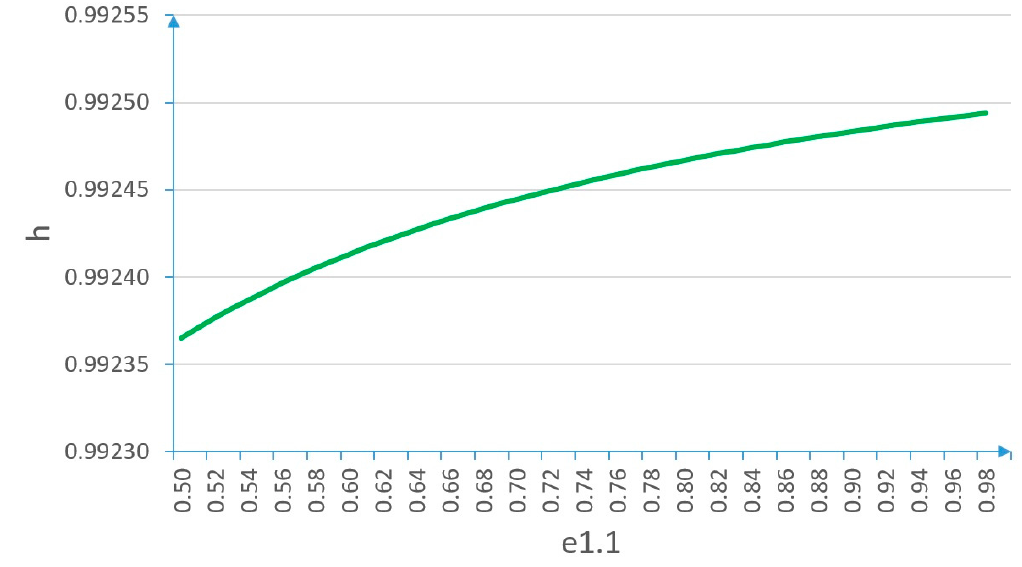
Figure 10. CQoPS simulation result in the e1.1 observation function. The result of the operation of software written by one of the authors of the article.